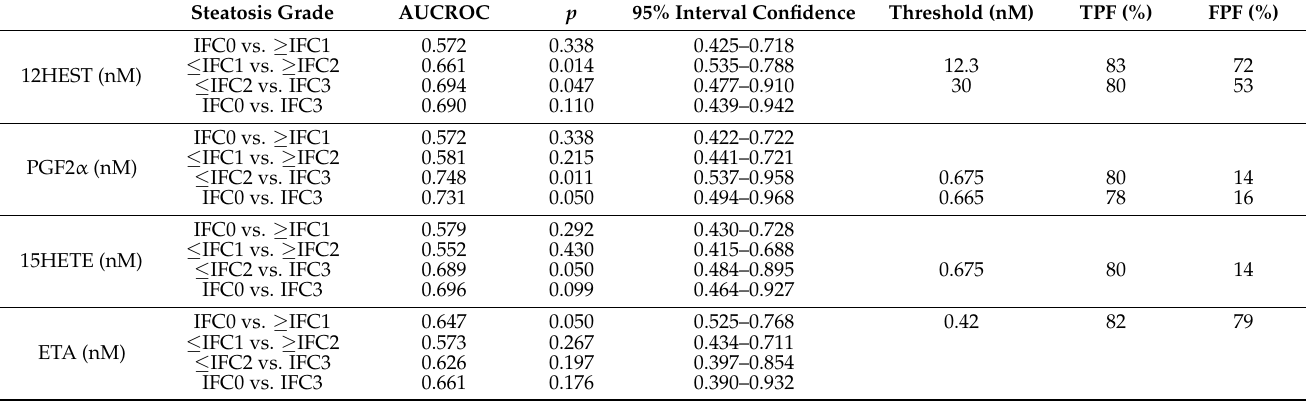
Table 5. Diagnostic accuracy of plasma oxylipin or free fatty acid levels for grading hepatic steatosis. Steatosis